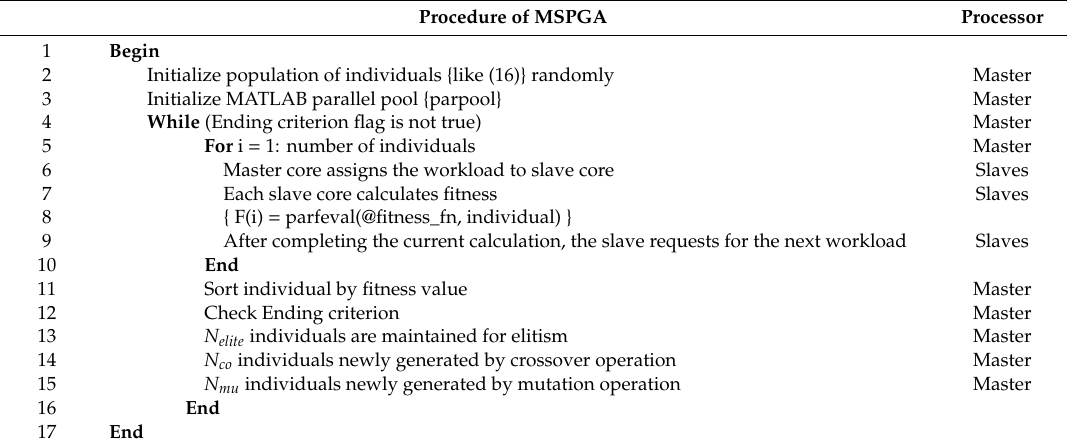
Table 3. Pseudo code for master–slave parallel genetic algorithm (MSPGA) using